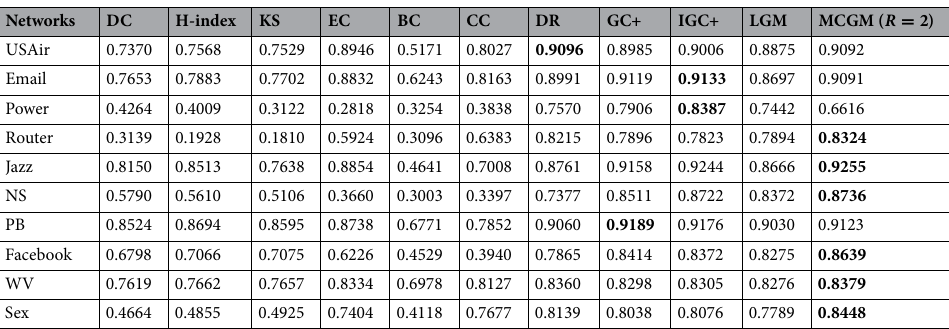
Table 5. The algorithms’ accuracies of MCGM with R = 2 and the benchmark algorithms measured by Kendall’s Tau for β = β c . For each network, the best algorithm is emphasized by bold.